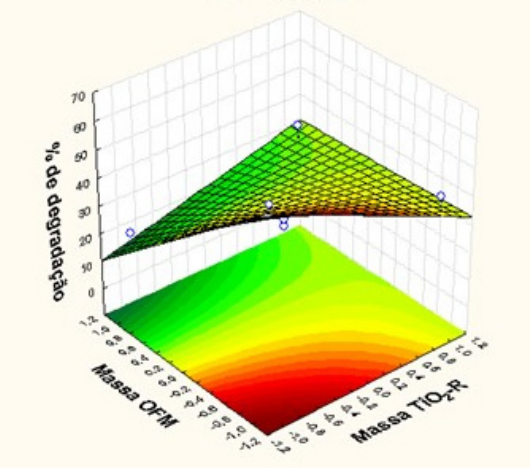
Figure 2. Surface graphics for TiO 2 -R/Fe 3 O 4 ratio.